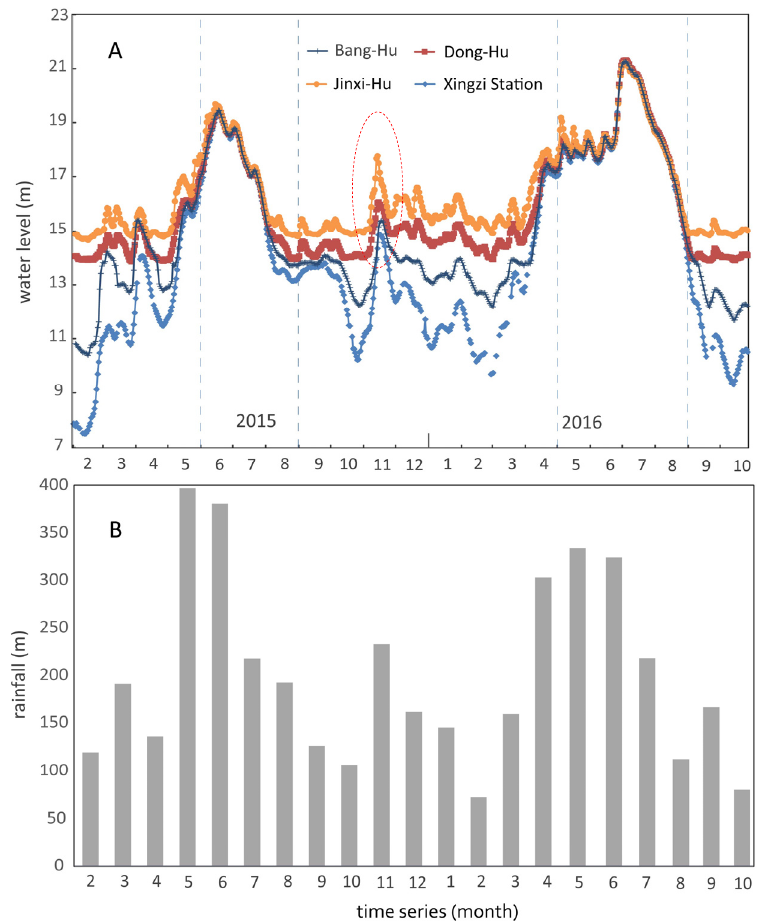
Figure 3. Comparison of lake/depressions water level (m) and rainfall (mm/month) from 2015 to 2016. Sub-figure ( A ): Water level changes in the saucer-shaped depressions and main lake showing the duration of connection and isolation phases in different periods. The red dotted line highlights a period of increases precipitation. Sub-figure ( B ) The pattern of rainfall variation within the Poyang Lake basin.